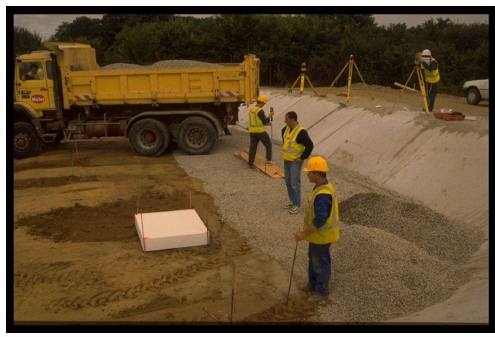
Figure 7. Placement of one of the polystyrene blocks in the silt section.